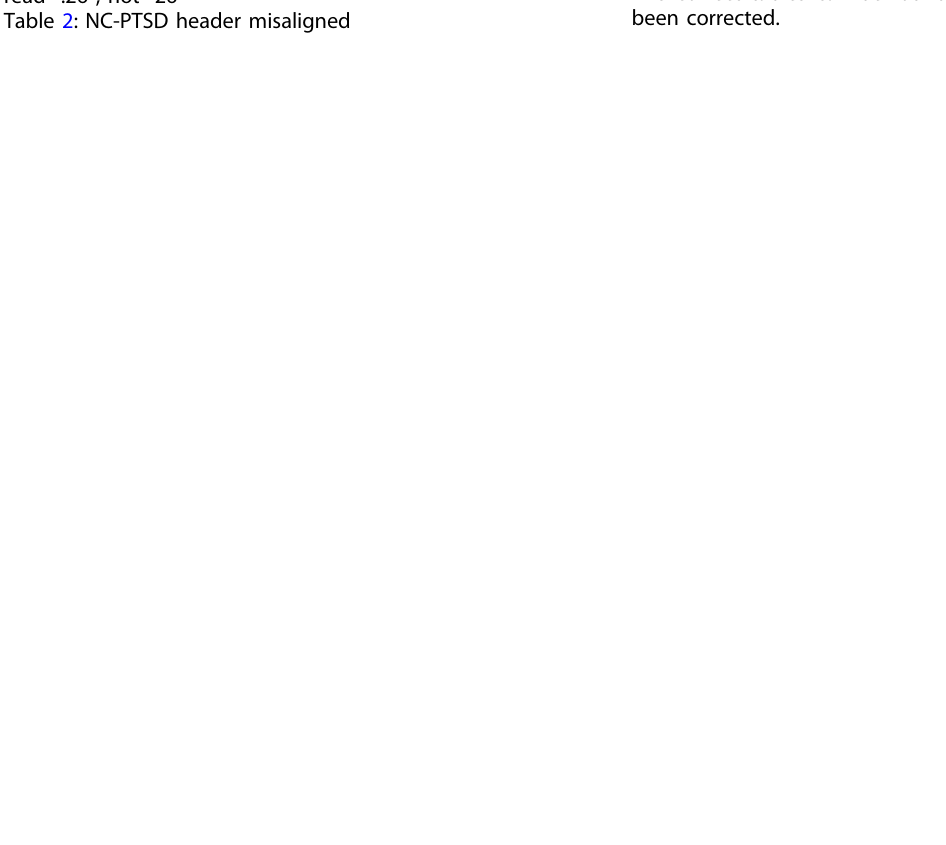
● Table 1: Standard deviation for IL10 (NCPTSD column) should